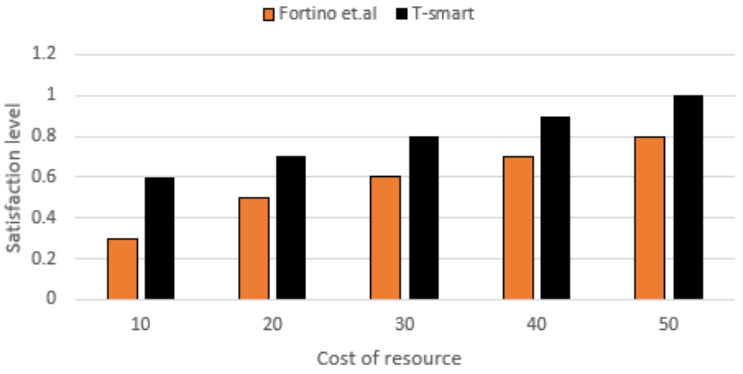
Figure 11. Satisfaction level with respect to